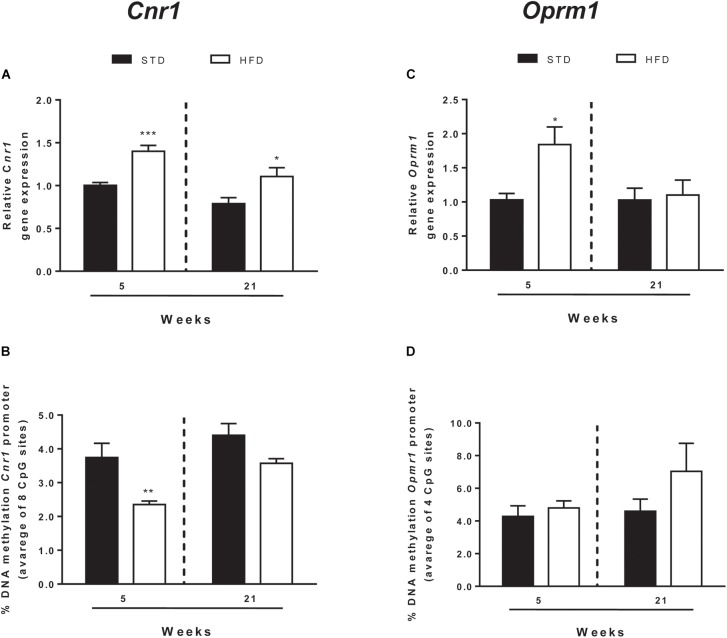
Cnr1 and Oprm1 transcriptional regulation. Cnr1 relative gene expression (A) and DNA methylation at gene promoter (B) and Oprm1 relative gene expression (C), and DNA methylation at gene promoter (D) analyzed in the hypothalamus of rats exposed for 5 and 21 HFD and/or STD Gene expression data are reported as 2-DDCt values calculated by Delta–Delta Ct (DDCt) method vs. STD (5 weeks) posed equal to 1. DNA methylation data are presented as the mean of the methylation % values of individual CpG sites under study as well as of the average (Ave) of the eight CpG sites ± SEM. ∗∗∗P < 0.001, ∗∗P < 0.01, ∗P < 0.05 vs. STD.